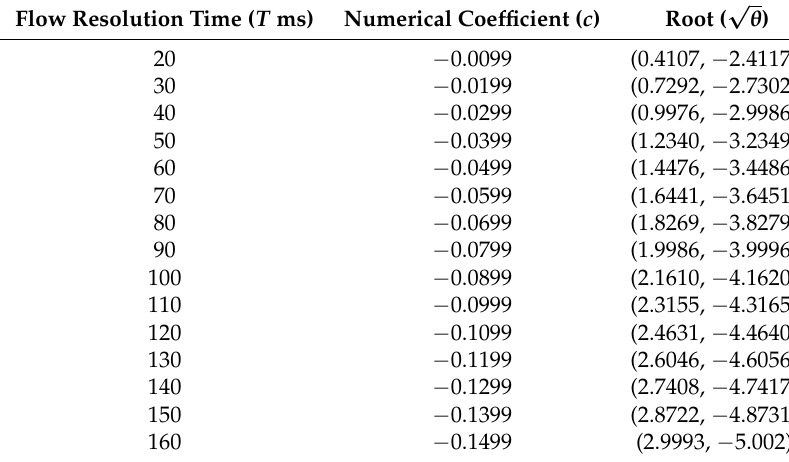
Table 3. Numerical Co-efficient and